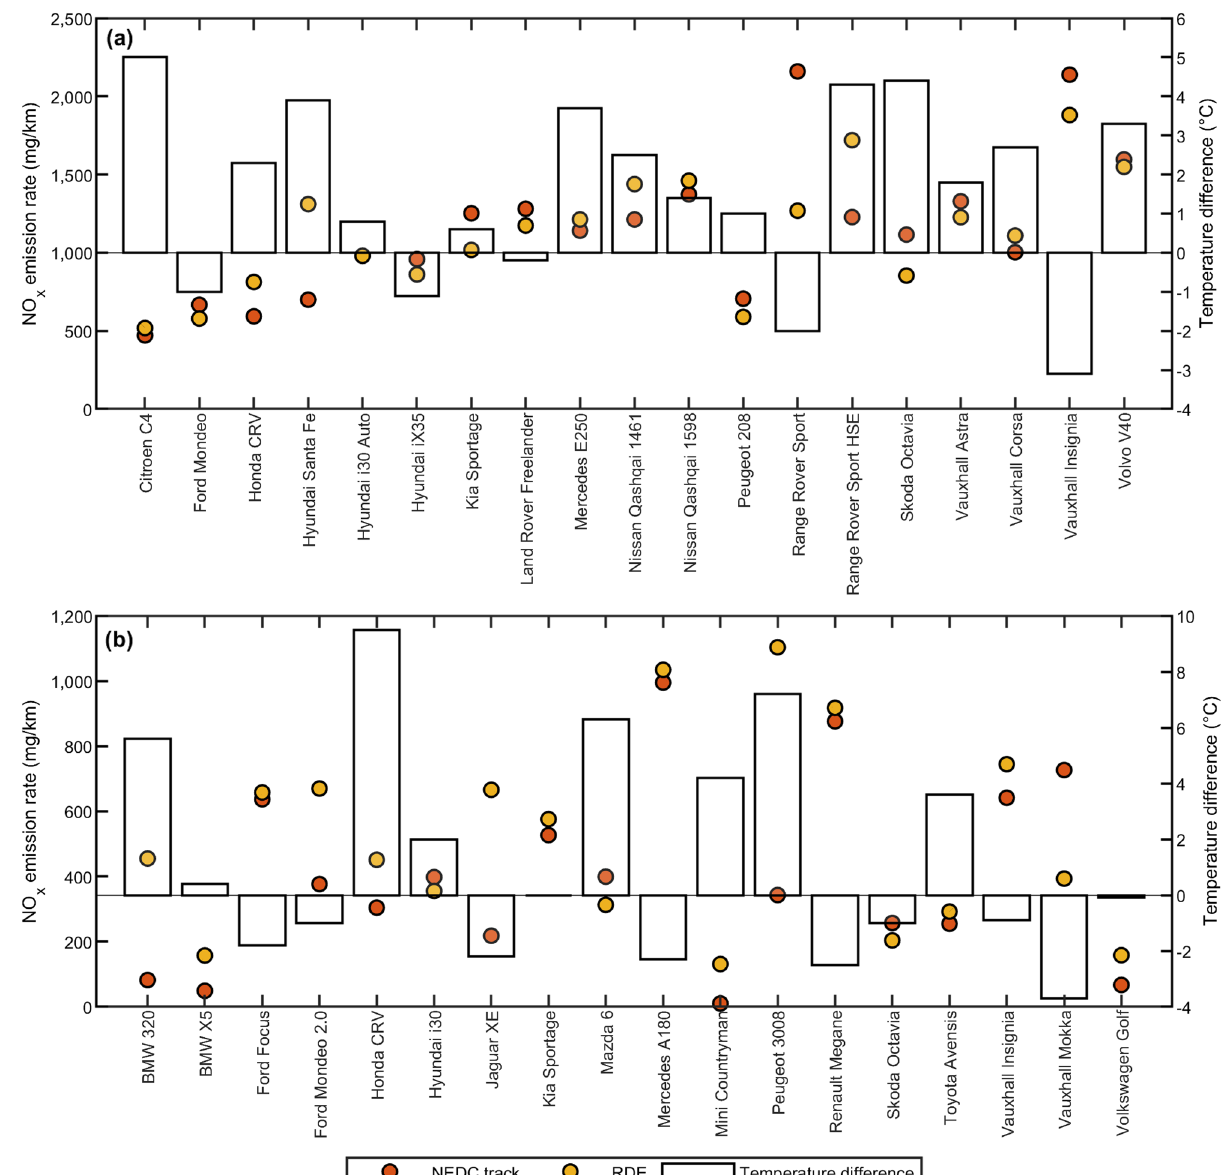
Figure 2. NO x emission rates of tested vehicles in NEDC track and RDE tests, alongside the respective differences in ambient testing temperature between the two tests. ( a , b ) Euro 5 vehicles ( a ), Euro 6 vehicles ( b ). Circular points represent the NO x emission rates. Bar heights represent the temperature difference, which is defined as the NEDC track test temperature minus the RDE test